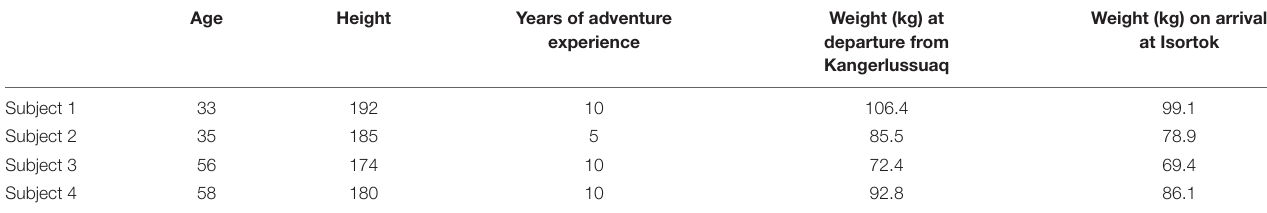
TABLE 1 | Subjects’ characteristics.